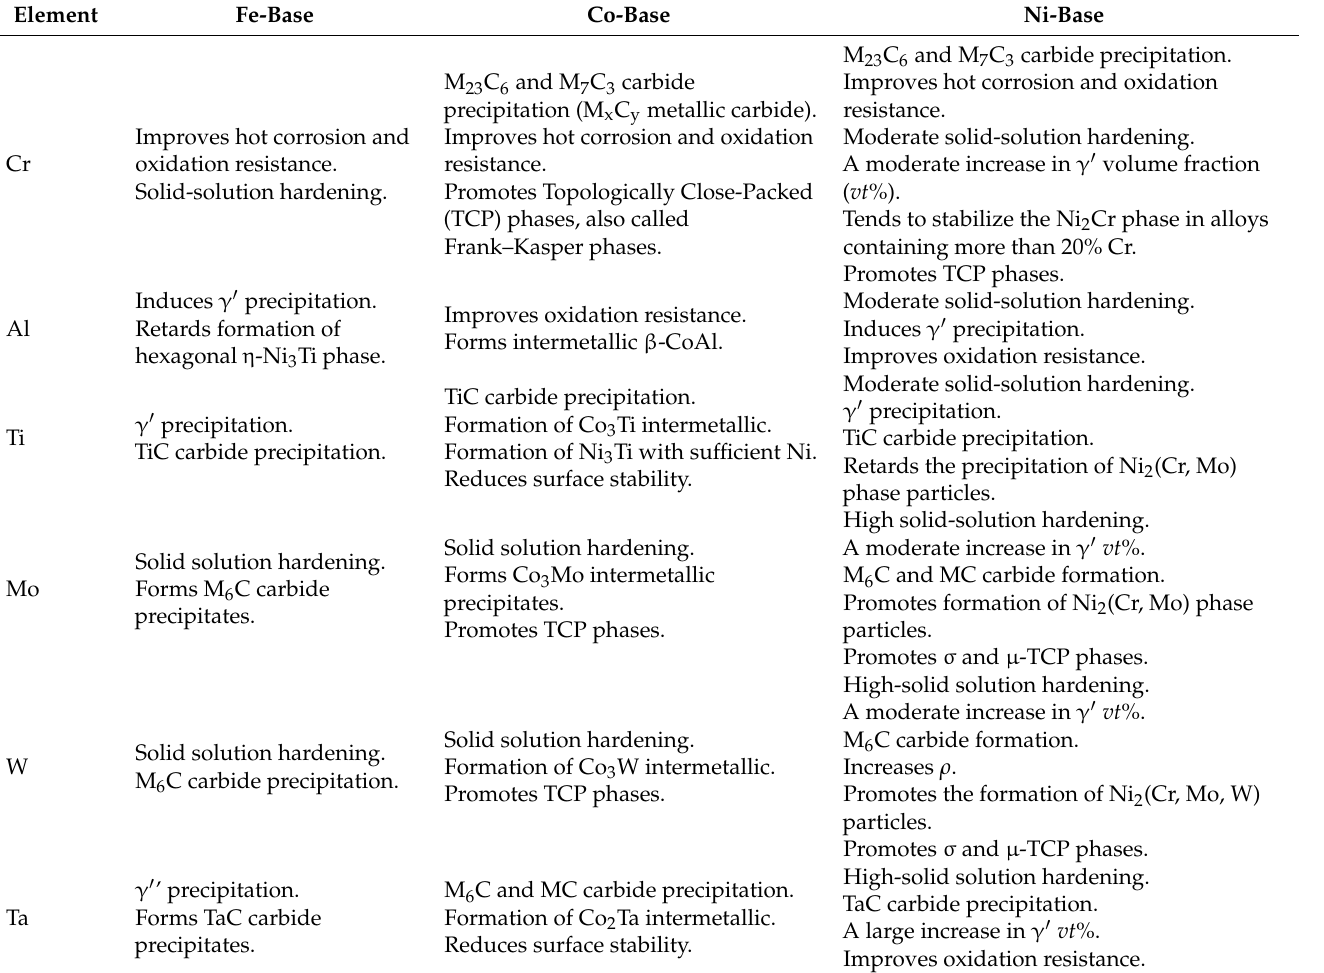
Table 3. Major roles of solutes in different types of INCONEL ® alloys